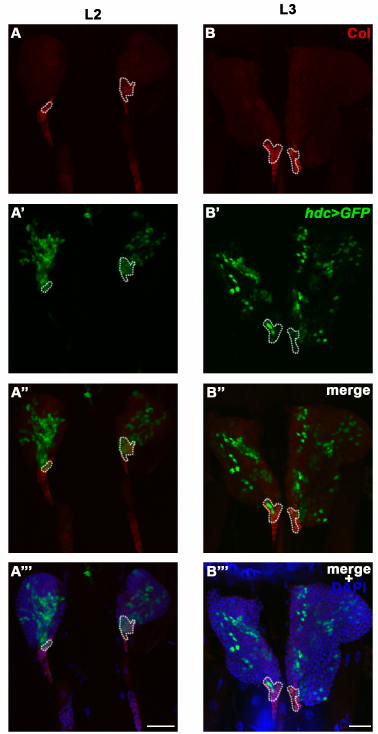
Figure 4. Overlap of hdc>GFP and Collier expression in the posterior signaling center (PSC) of the lymph gland. ( A – B ) PSC was labeled with anti-Collier staining (red) of the lymph gland of L2 ( A ) and L3 ( B ) larvae; ( A’ – B’ ) The expression of hdc was monitored by the expression of the GFP marker (green) in second- ( A’ ) and third instar ( B’ ) hdc19-Gal4/UAS-2xEGFP larvae; ( A” – B” ) hdc>GFP (green) and Collier (red) expressions overlap in the PSC of the lymph gland; ( A”’ – B”’ ) DAPI staining (blue) of lymph gland cells. Images were taken with a Leica TCS SP5 Confocal Microscope, original magnification × 20, and processed with LAS AF Lite (Leica Microsystems CMS GmbH), ImageJ and Adobe Photoshop CS2 softwares. Scale bars: 25 µm.